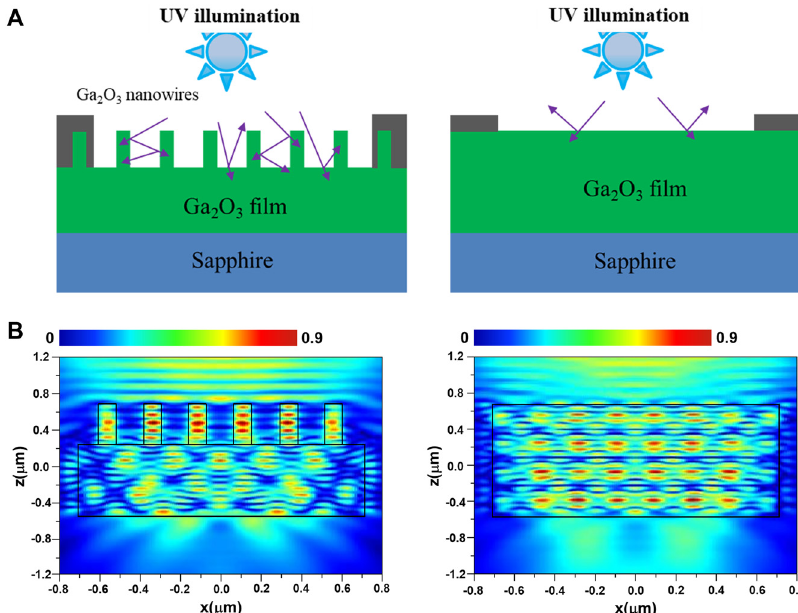
Figure 4: (A) Schematic illustration of the respective light-trapping mechanisms and (B) the simulated light fi eld intensity dis- tribution in β -Ga 2 O 3 nanowire and fi lm photodetectors